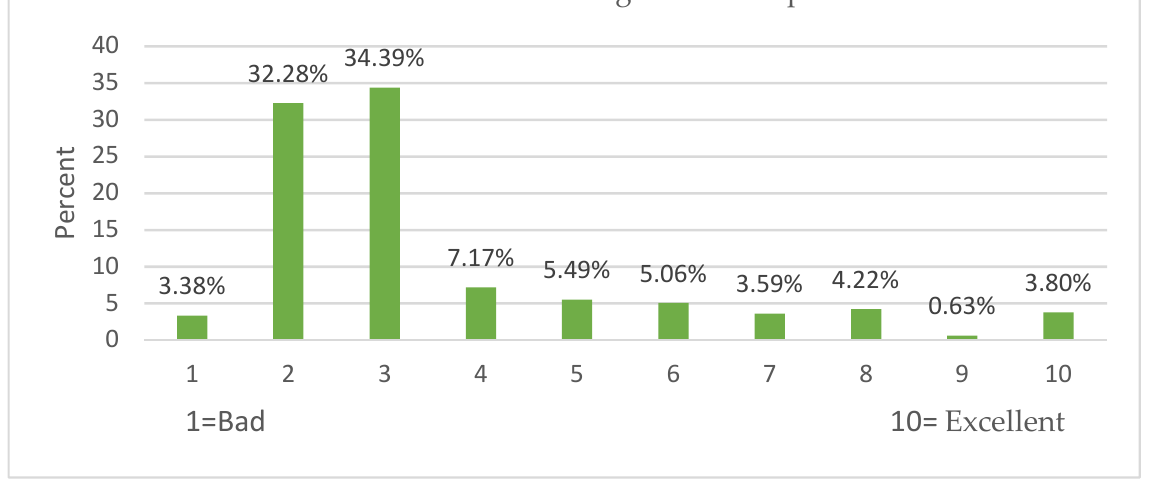
Figure 4. Evaluation of online course contents during lockdown .